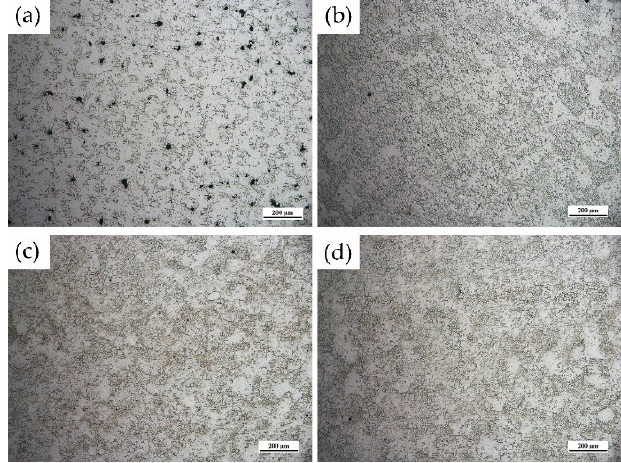
Figure 9. Transverse morphology of the same VED (370.37 J/mm 3 ).